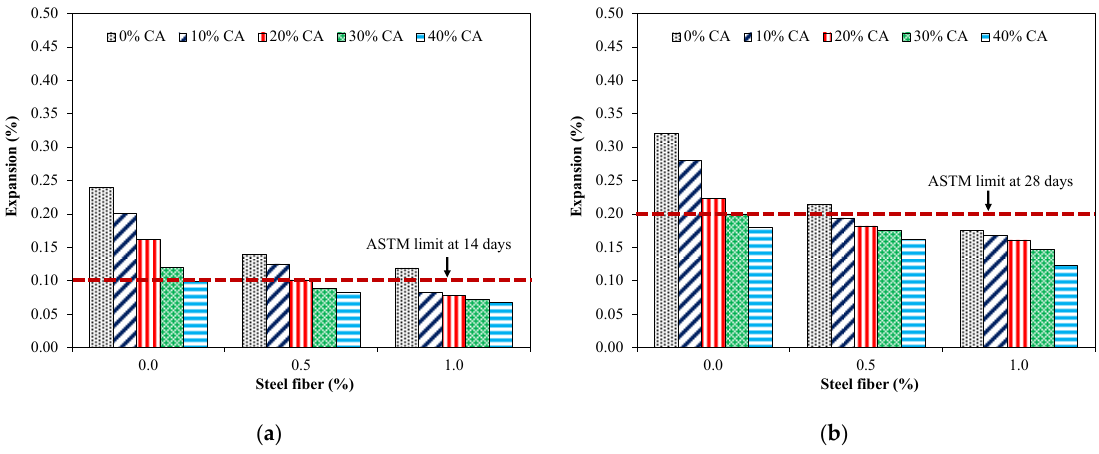
Figure 13. ASTM limits for expansion incorporating coal ash and steel fibers: ( a ) 14 days; ( b ) 28 days. Similarly, it was observed that a higher dosage of steel fibers exhibited a further decrease in expansion compared to that of the tested lower dosage of steel fibers. For instance, the control specimen incorporating 1% of steel exhibited an expansion of 0.175% at 28 days compared to that of 0.214% at 28 days for the identical specimen with 0.5% of steel fibers. The expansion was further decreased for specimens with 1% of steel fiber and higher proportions of CA. The minimum expansion was observed for the specimen with 1% of steel fibers and 40% of CA at 90 days. Figure 14a shows the SEM image of the specimen incorporating 30% of CA exposed to ASR conditions. No micro-cracks were observed due to the incorporation of 30% of CA. Moreover, micro-cracks were restrained by the steel fibers for specimens incorporating 10% of CA and 1% SF (Figure 14b).